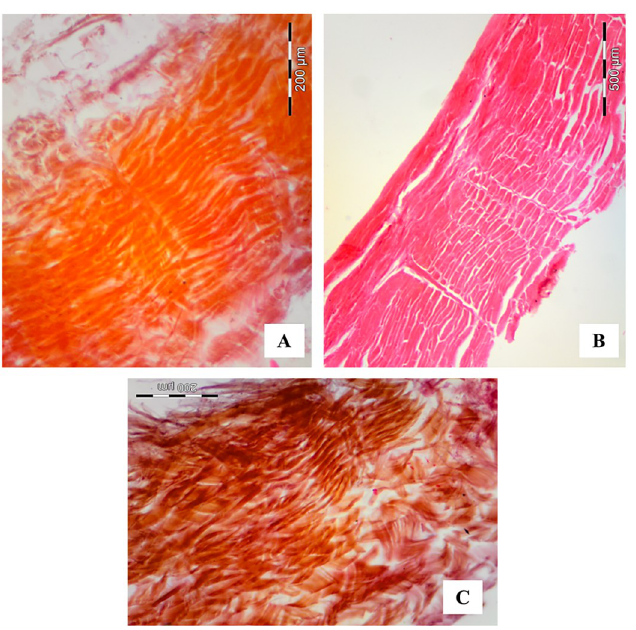
Fig 4. Photomicrographs of the paiche ( A . gigas ) leather cuts in different directions in relation to the length of the fish’s body, slides in HE staining. (A) longitudinal direction, (B) transverse direction and (C) diagonal direction.